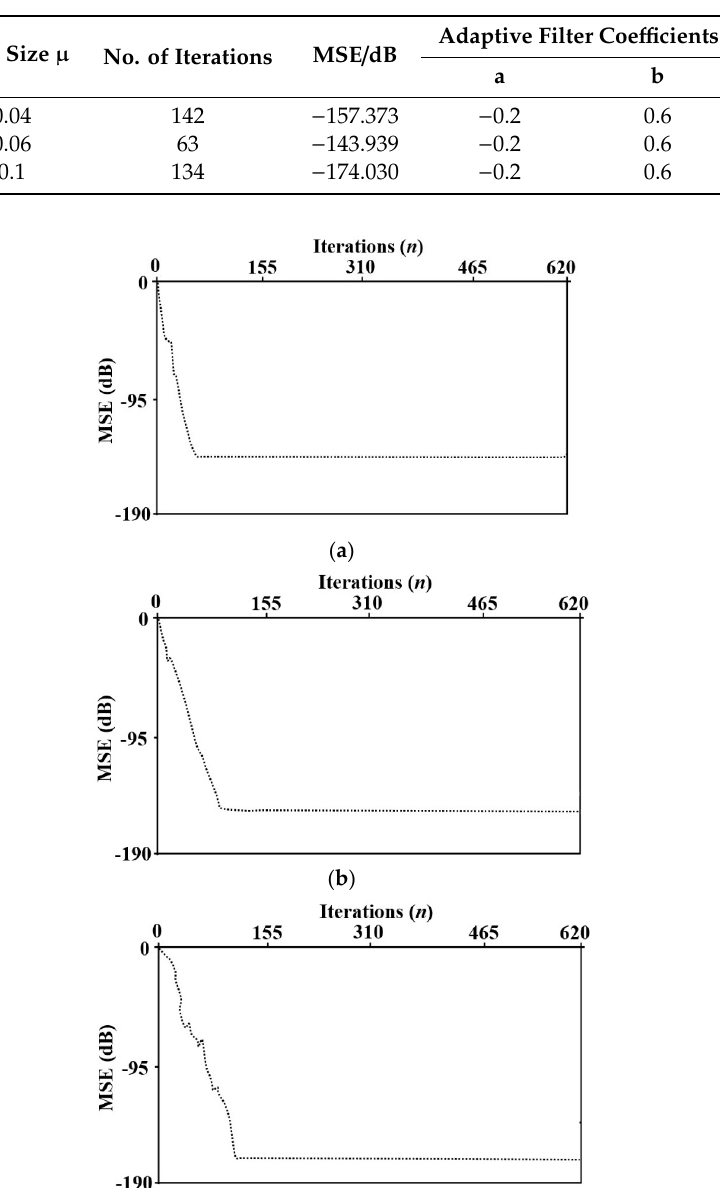
Figure 17. The learning curves for the case of IIR adaptive filter, ( a ) 𝜇 = 0.06 , ( b ) 𝜇 = 0.04 , and ( c ) 𝜇 = 0.1